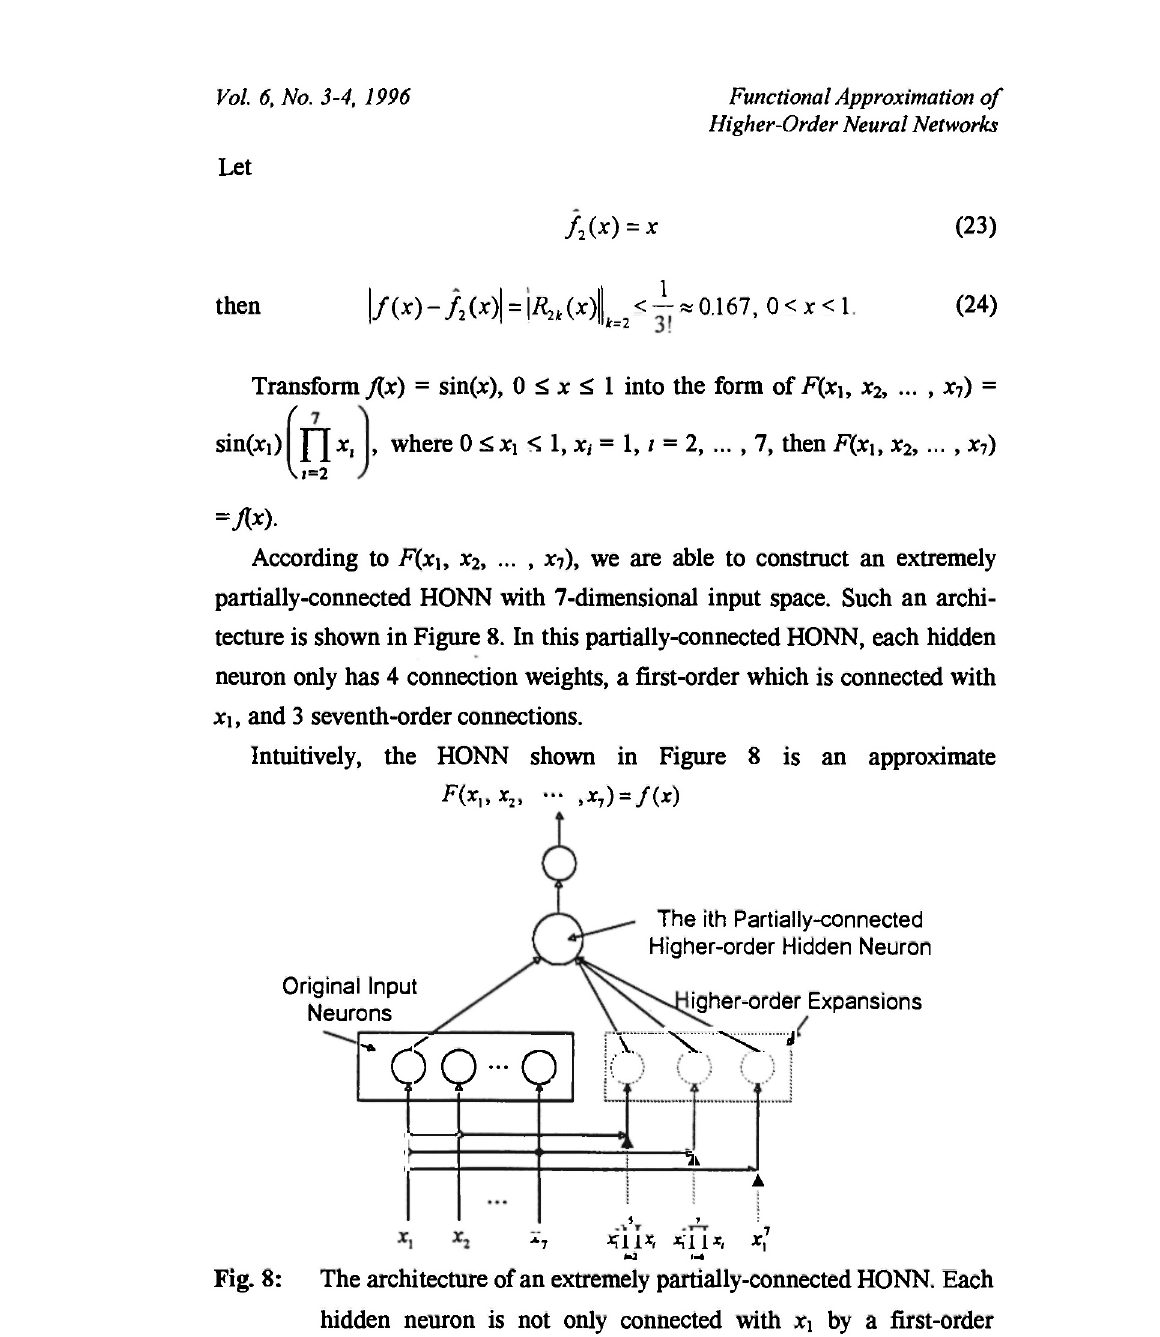
5 7 , x, 7 by 3 ; i=2 i=6